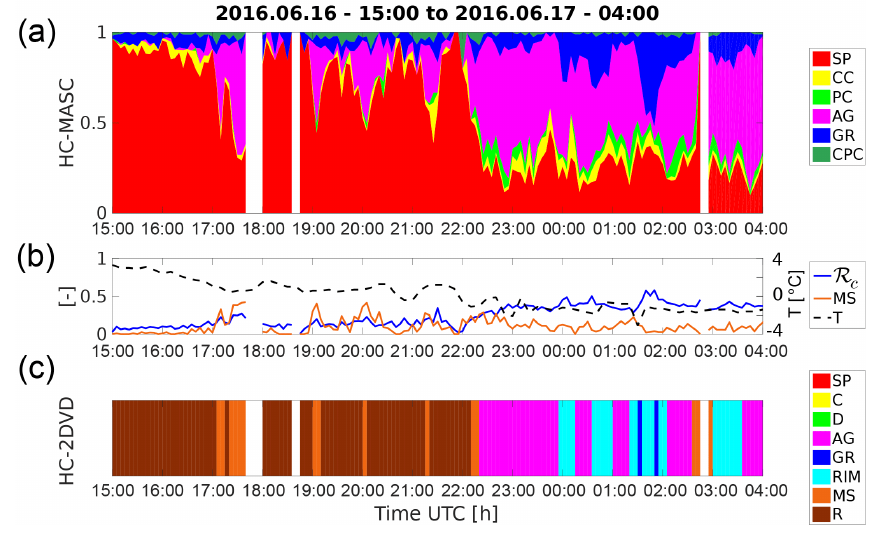
Figure 14. Same as on Fig. 13 but for 16–17 June